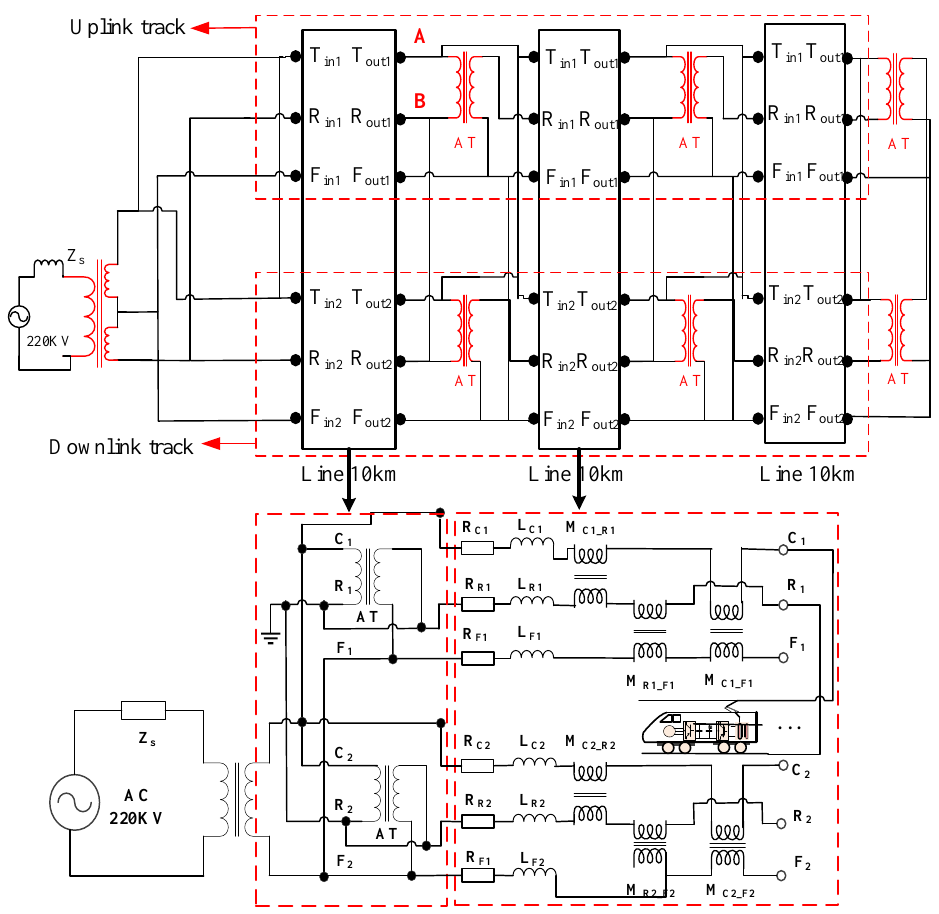
Figure 14. The simulation model of traction power supply system. AC: alternating current.